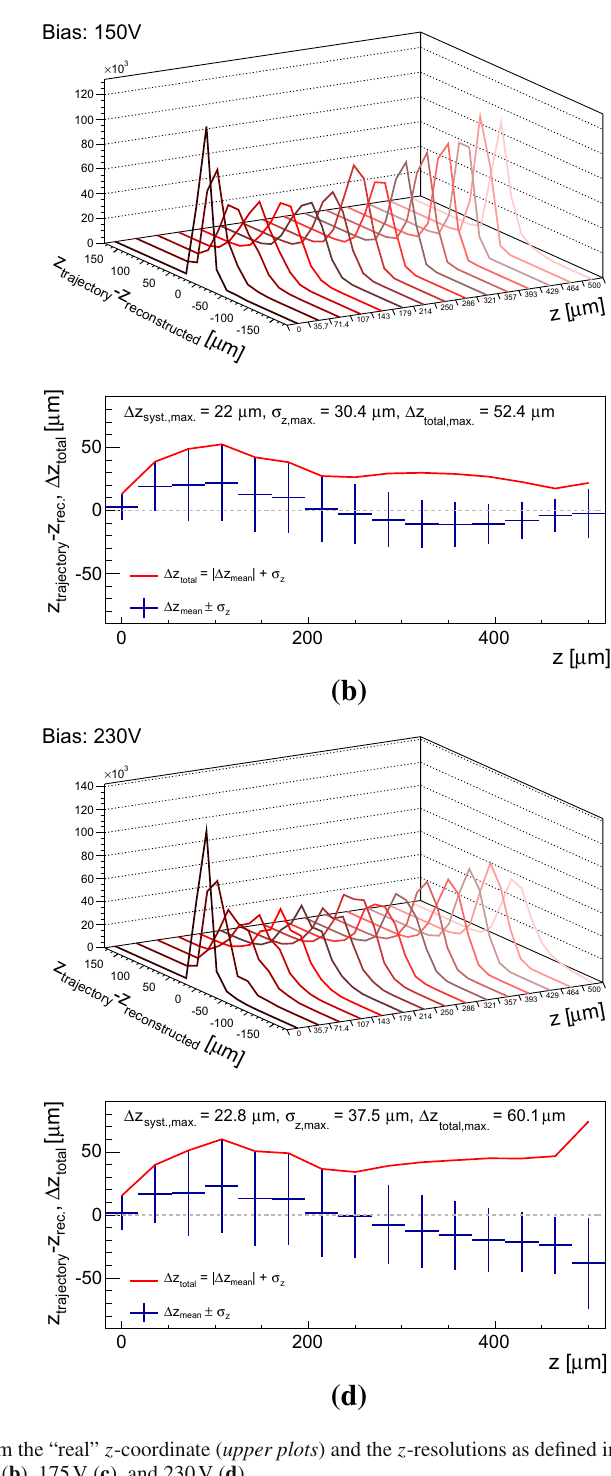
the bias voltages 175 and 230V, the drift time model additionally underestimates the measurement at high z , indicating that the real electric field is lower than in the linear